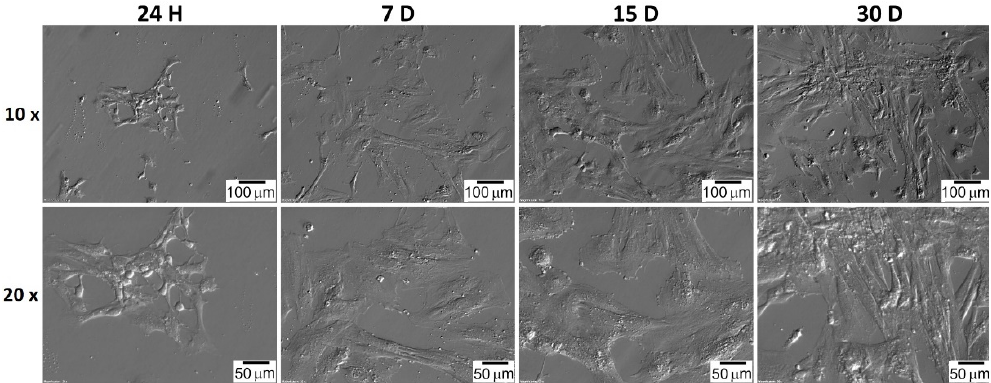
Figure 7. CC’s morphology over 30 days in vitro culture. H: hour of culture, D: day of culture.